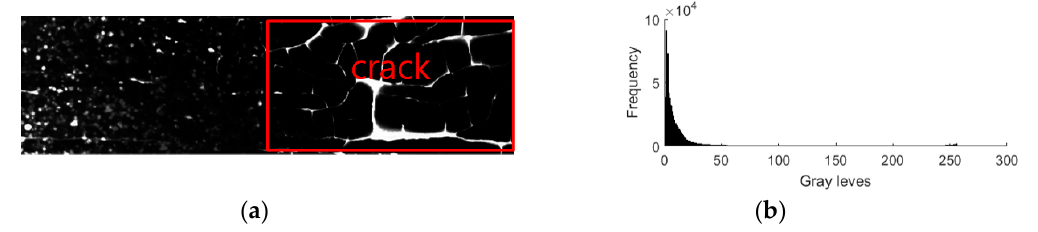
Figure 7. ( a ) Droplets image of 1.5 × 10 − 2 cm ink; ( b ) its grayscale pixel distribution curve.